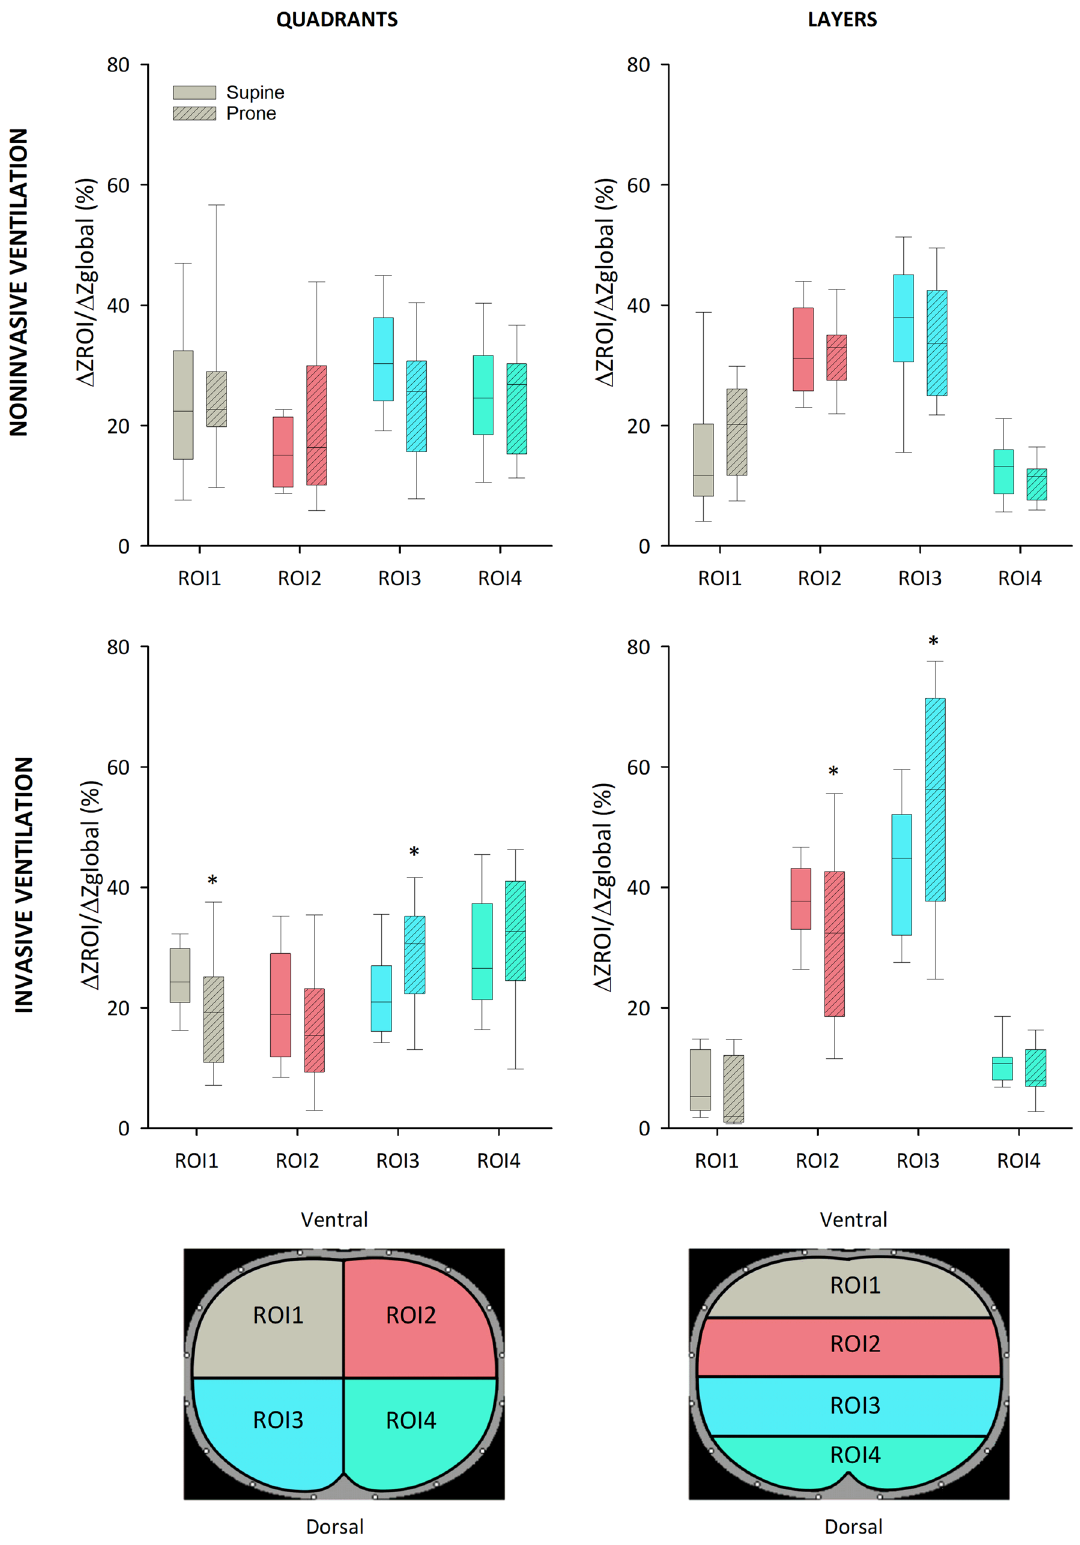
Figure 2. Regional ventilation assessed by regional tidal impedance variations relative to global tidal impedance variation (∆z ROI /∆z global ) obtained by electrical impedance tomography for non-invasively and invasively ventilated patients. Empty boxes indicate data acquired in prone position; boxes with diagonal line pattern indicate data acquired in supine position. Regions of interest (ROIs) were defined as quadrants or layers. *: p < 0.05 versus supine